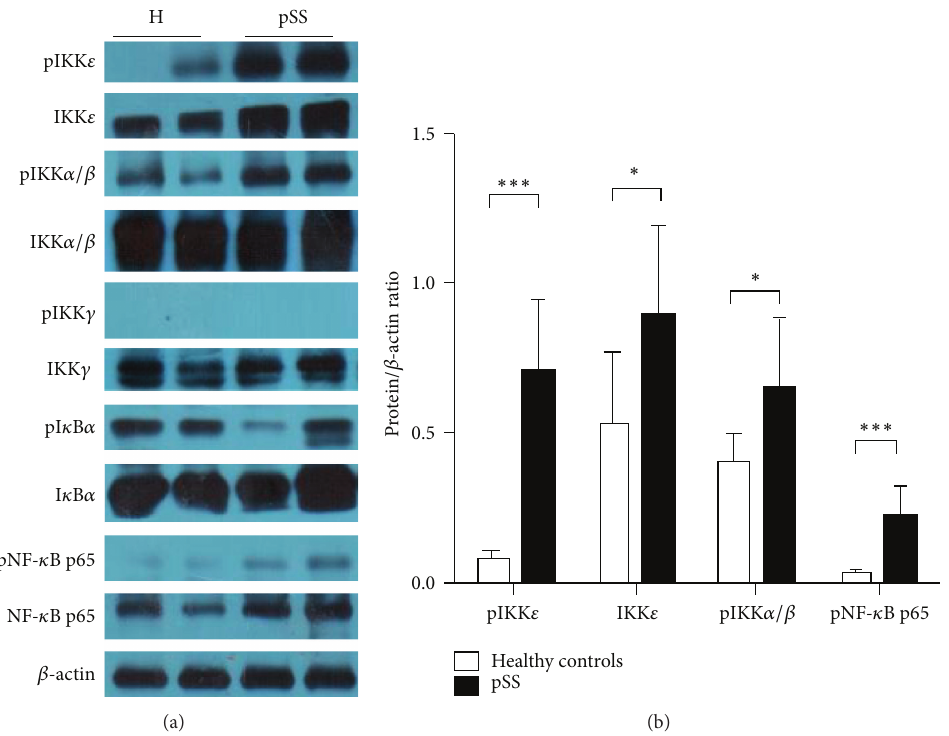
Figure 2: Protein expression of pIKK 𝜀 , total IKK 𝜀 , pIKK 𝛼 / 𝛽 , and pNF- 𝜅 B p65 were significantly increased in PBMC from patients with pSS, compared to healthy controls. (a) Phosphorylated and total protein expression of IKK 𝜀 , IKK 𝛼 / 𝛽 , IKK 𝛾 , I 𝜅 B 𝛼 , and NF- 𝜅 B p65 in PBMC from two healthy controls (H) and two representative pSS patients was shown by western blot. (b) The relative expression of pIKK 𝜀 , total IKK 𝜀 , pIKK 𝛼 / 𝛽 , and pNF- 𝜅 B p65 were higher in pSS ( 𝑛 = 33 ), compared to healthy controls ( 𝑛 = 26 ). 𝛽 -actin was used as endogenous control, and relative expression of each protein is shown as protein/ 𝛽 -actin ratio. ∗ 𝑃 < 0.05 ; ∗∗∗ 𝑃 < 0.001 . All data are representative of three independent